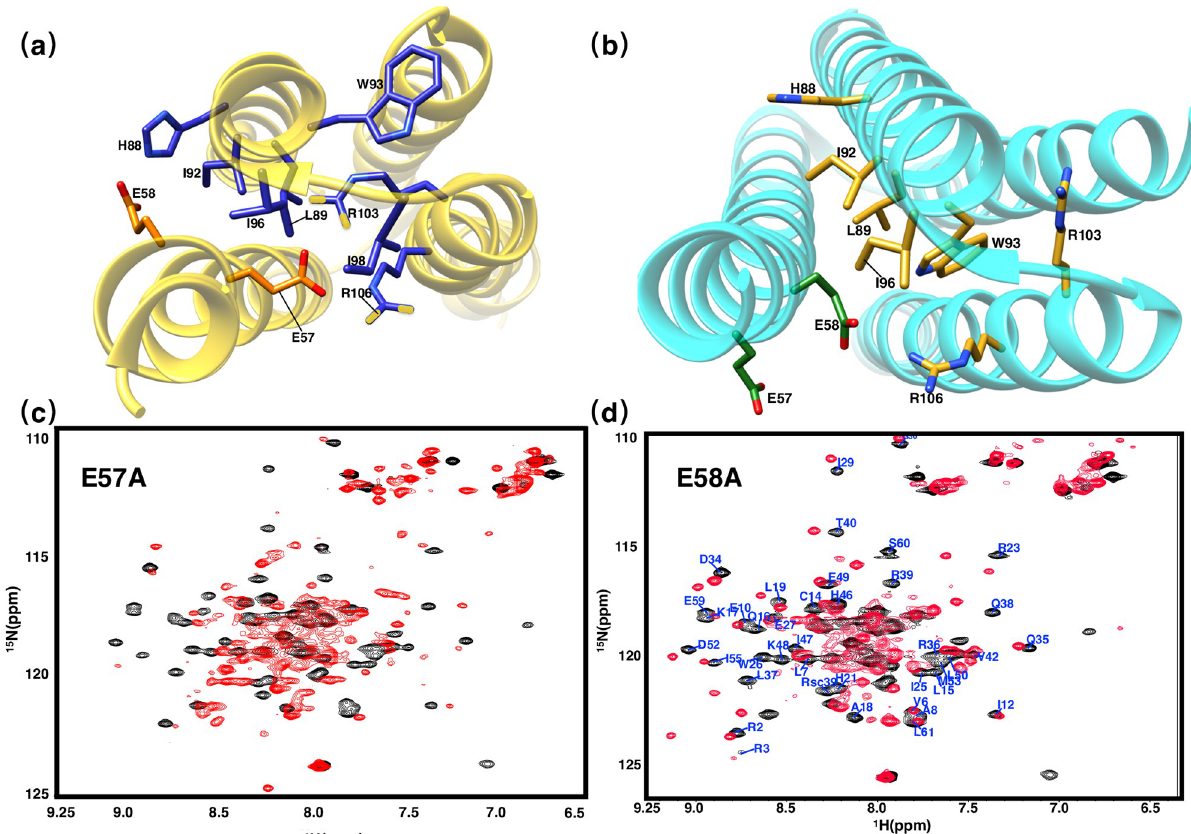
Fig 9. Two-dimensional 1 H - 15 N HSQC spectra of E57A and E58A. (a)-(b) Ribbon representation of the solution structure (gold) and crystal structure (cyan) with the side chains E57 and E58 in orange and green while the side chains of the residues interacting with E57 or E58 shown in blue and mud yellow for solution and crystal structures respectively. (c) Two-dimensional 1 H - 15 N HSQC spectra of E57A. (d) Two-dimensional 1 H - 15 N HSQC spectra of E58A, all residues with significant chemical shift changes ( Δ comp � 0.3 ppm) were labeled.